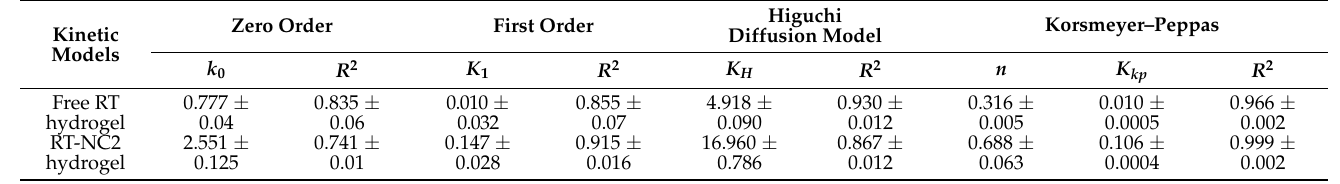
Table 6. Kinetic parameters of various models of RT release data from free RT and RT-NC2 hydrogels. Kinetic